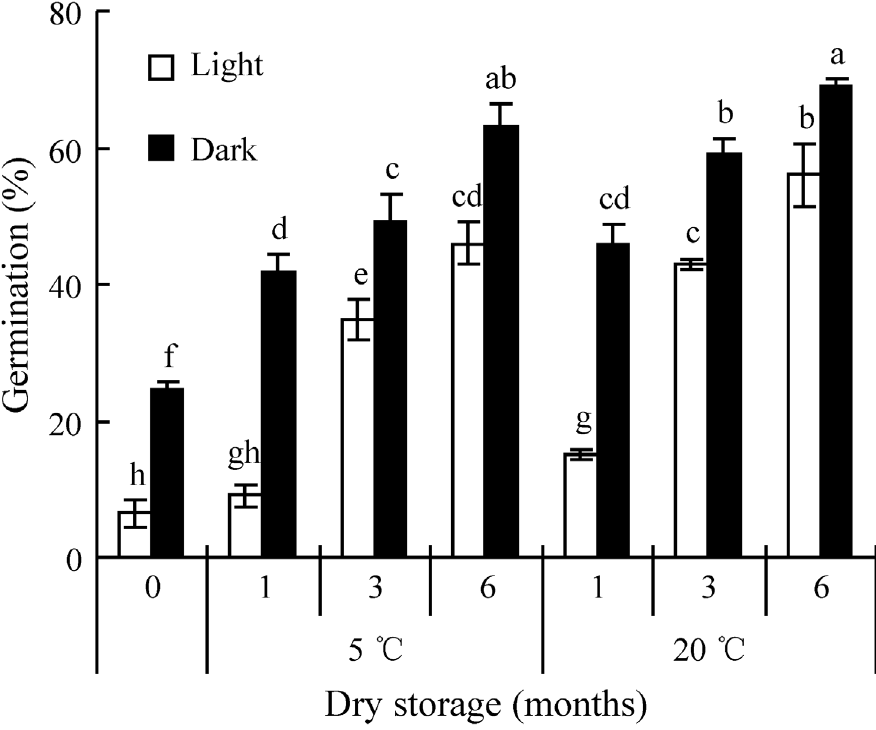
Figure 3. Effect of dry storage (afterripening) on germination of seeds of Stipabungeana in a 12 h/12 h photoperiod and in dark at 20 u C. Different letters indicate significant difference (P , 0.05) among all treatments (n=4).